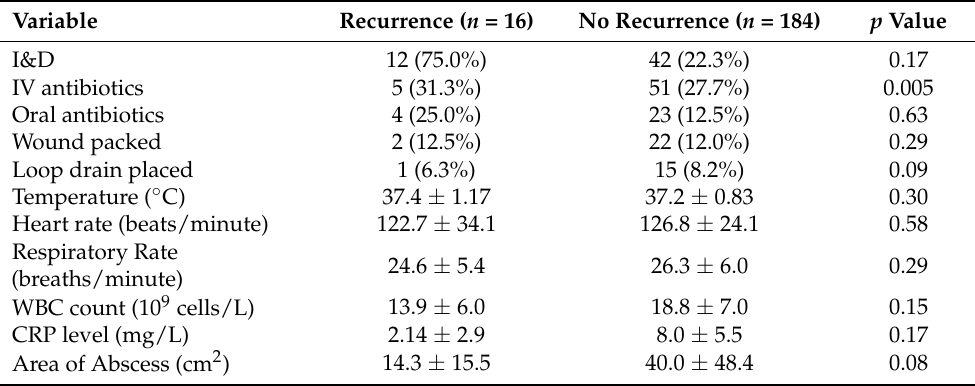
Table 4. Factors associated with abscess recurrence within 30